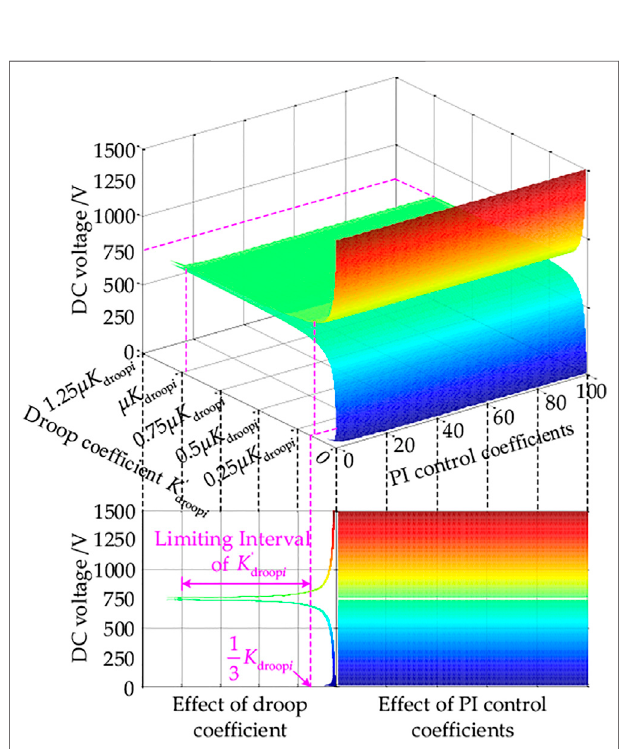
FIGURE 5 | Control system response relationship of VSC-MTDC power distribution.